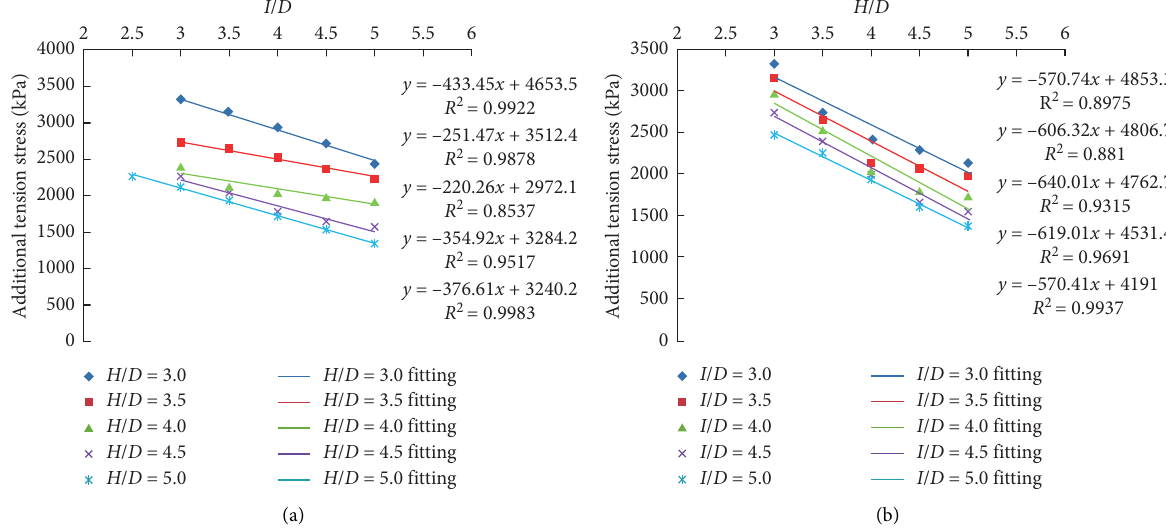
Figure 11: Variation of the maximum peak of additional tensile stress with H / D and I / D , respectively. (a) Variation of the maximum peak of additional tensile stress with I / D under different H / D . (b) Variation of the maximum peak of additional tensile stress with H / D under different I / D